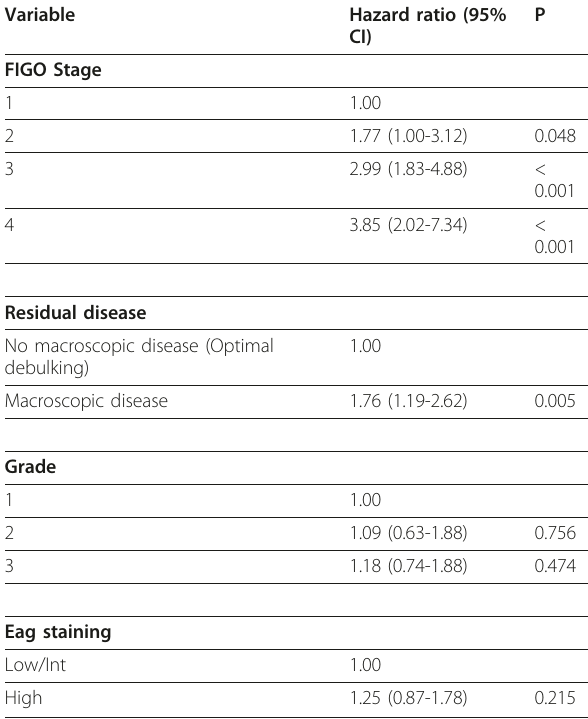
Table 4 Cox proportional hazard model of overall survival using Eag staining (Low/Int versus high) with other prognostic